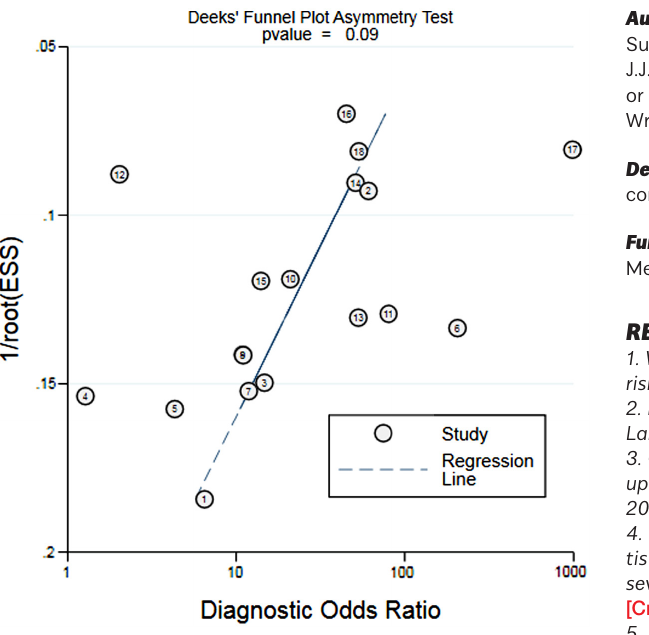
Figure 7. Result of publication bias by Deeks’ funnel plot asymmetry